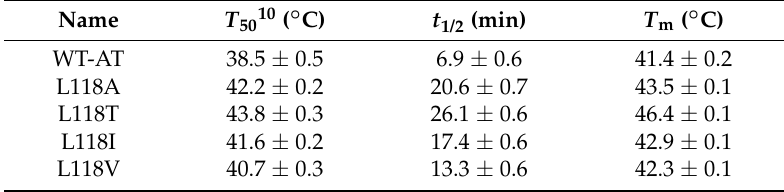
Table 1. The stability of the wild-type and stabilized mutant AT-ATAs.